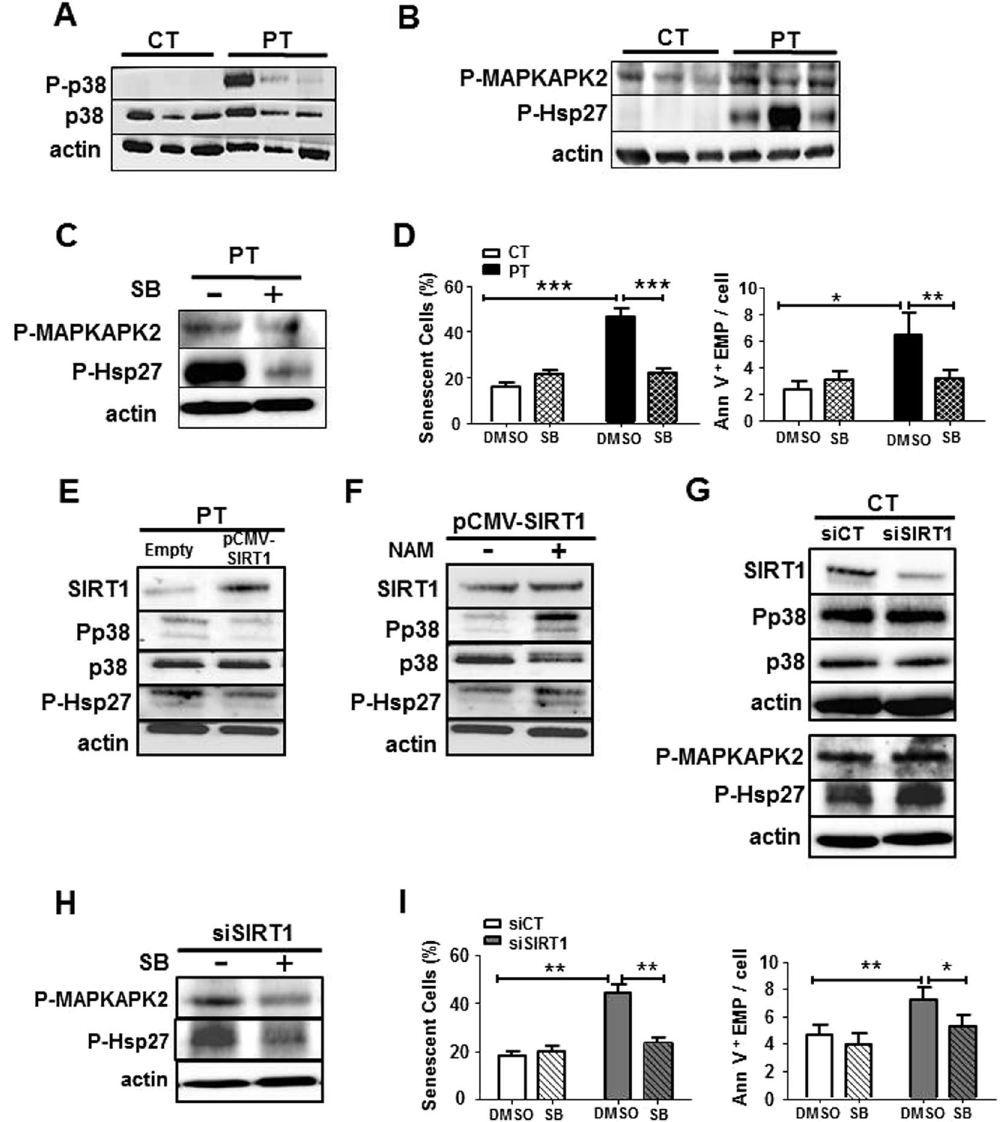
Figure 5. SIRT1 protects against senescence and vesiculation through the downregulation of the p38 MAPK pathway activation in ECFC. ( A ) The level of P-p38 and total p38 were examined through Western blot analyses in CT- and PT-ECFC (N = 11 vs 18). ( B ) Western blot analysis of p38 MAPK activation in CT- and PT-ECFC was performed by the determination of phosphorylation of MAPKAPK2 and Hsp27 (N = 11–18 vs 13–28) ( C ) Western blot analysis was performed to determine the levels of P_MAPKAPK2 and P-Hsp27 in PT-ECFC treated with 2 µ M of the p38 MAPK activity inhibitor, SB203580 (SB). ( D ) The effect of SB203580 treatment on CT- and PT-ECFC (2 µ M, 48 h, N = 6 vs. 14) on senescence and EMP release. Left panel: quantification of ECFs positive for SA β -galactosidase activity. Right panel: quantification of EMP release by flow cytometry using Annexin-V staining. ( E ) The impact of SIRT1 overexpression on p38 MAPK pathway activation in PT-ECFC (relative expression to empty; N = 8–11). ( F ) The impact of NAM on p38MAPK pathway activation (relative expression to SIRT1-transfected cells; N = 8–11) in PT-ECFC overexpressing SIRT1. ( G ) The impact of SIRT1 silencing on p38 MAPK pathway activation in CT-ECFC (relative expression to scrambled; N = 6–13). ( H,I ) The effect of SB203580 treatment on SIRT1-knockdown CT-ECFC was assessed on downstream effectors of p38 MAPK (H , N = 4–7) , as well as the percentage of ECFC positive for SA β -galactosidase activity (I , Left panel, N = 8) and EMP release (I , Right panel). The data for all of the bar graphs are presented as the means ± SEM. (Statistical analysis: One-way ANOVA, * p < 0.05, ** p < 0.01, *** p < 0.001). All blots correspond to representative images of blot